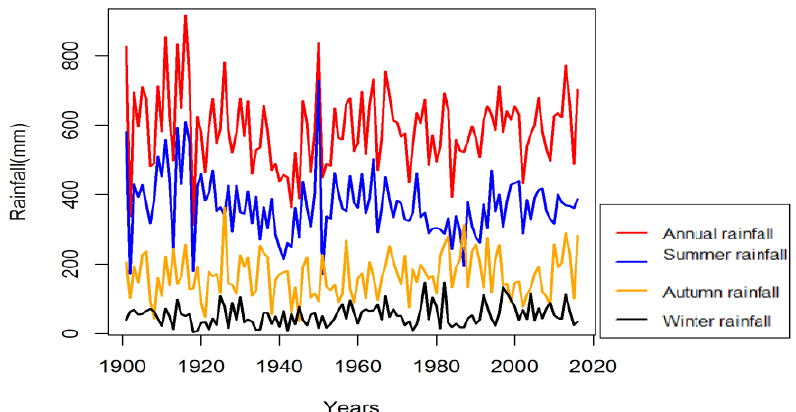
Figure 8. Annual and seasonal rainfall time series for the entire basin for the period 1900 – 2016.